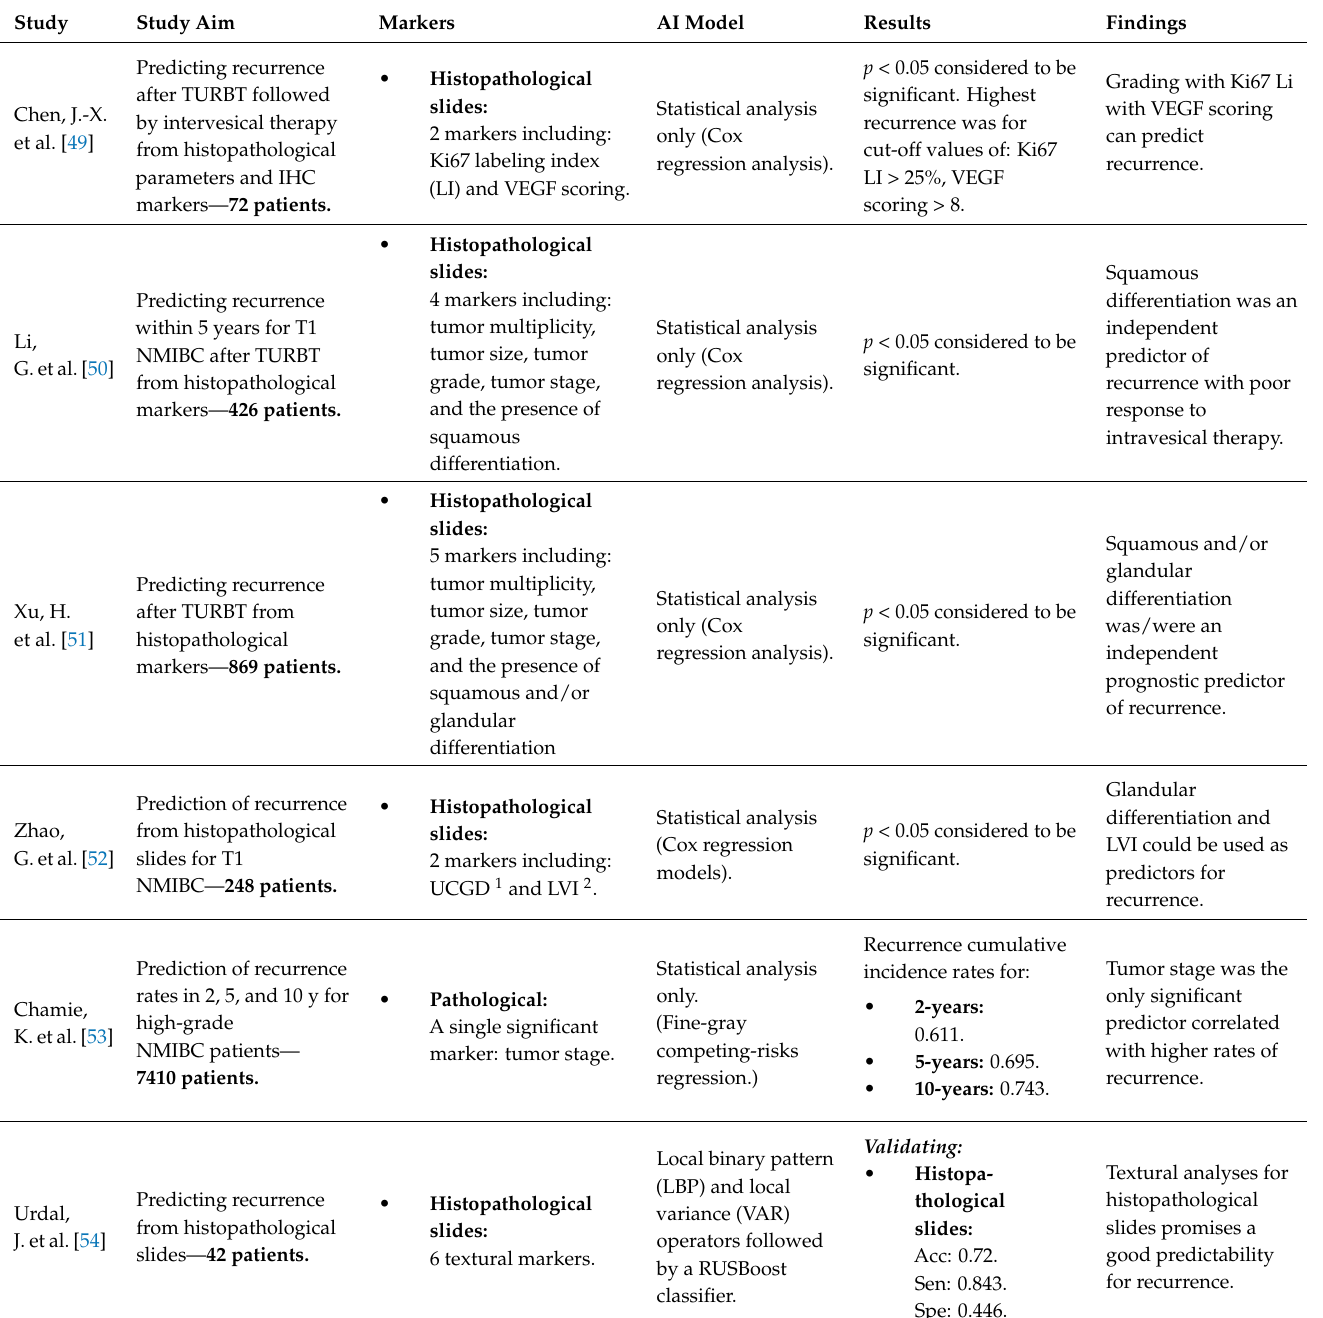
Table 2. Literature review on using histopathological parameters and IHC markers to predict recurrence in